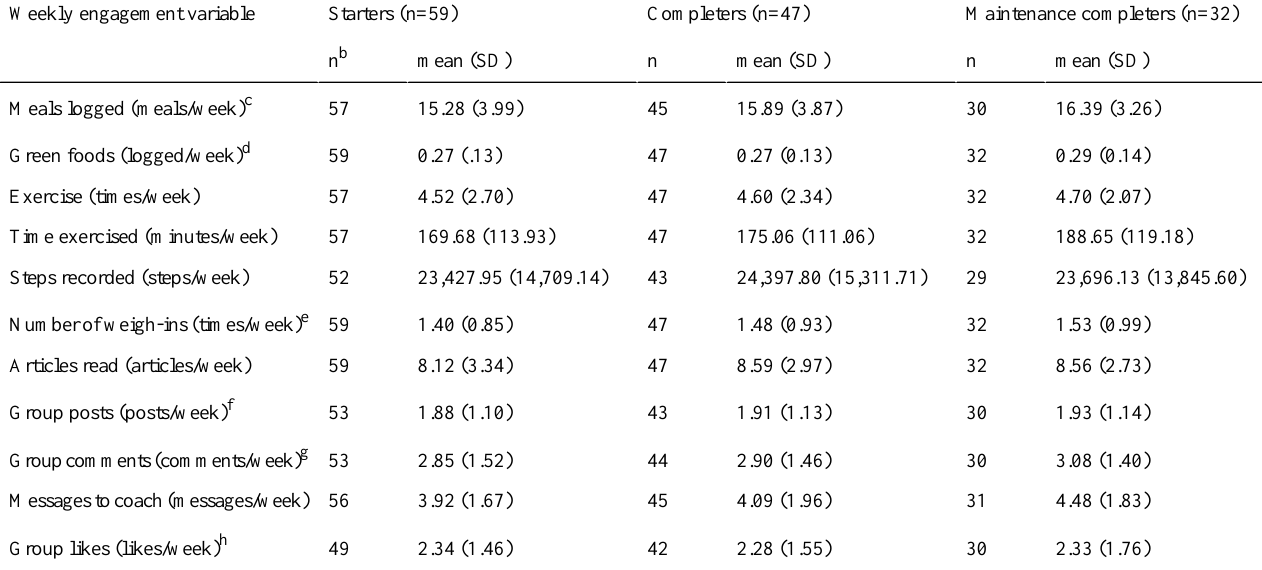
Table 4. Mean in-app a weekly engagement variables over 65